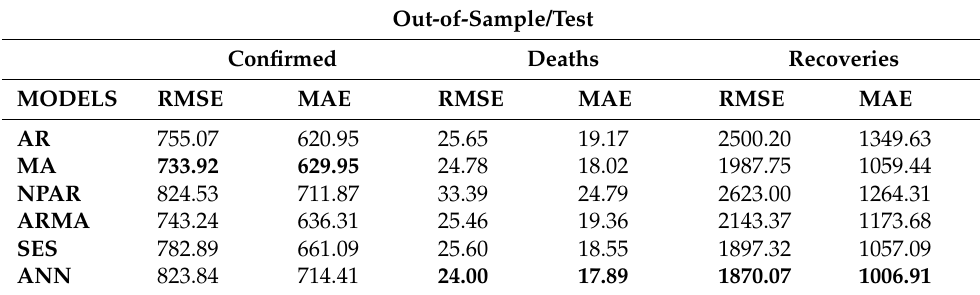
Table 4. Out-of-Sample/Test : One-day-ahead RMSE and MAE for confirmed cases, deaths, and recovered cases for all